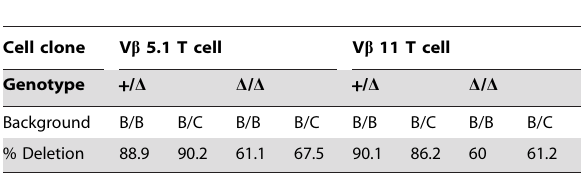
Figure 2. Thymic negative selection was partially reduced in the Foxn1 D / D mutant mice. Foxn1 D / D /BALB/c mice were generated by backcrossing Foxn1 D / D mice (H-2 b , IE - ) to BALB/c (H-2 d , IE + ) for more than 5 generations. Before and after backcrossing, the expressions of V b 5.1 and V b 11 were measured on CD4 T cells. A, histograms showing representative profiles of V b 5.1 and V b 11 expressions on gated CD4 T lymphocytes from Foxn1 + / D , Foxn1 D / D and BALB/c mice. B and D, individual analyses of V b 5.1 and V b 11 expression on CD4 T cells from Foxn1 + / D , Foxn1 D / D and BALB/c mice before backcrossing. C and E, individual analysis of the percentage of V b 5.1 and V b 11 from Foxn1 D / D mice after backcrossing. C/C: C57BL6 background (IE 2 /IE 2 ); B/B: BALB/c background (IE + /IE + ); B/C: BALB/c/C57BL6 (IE + /IE 2 ). (*, p , 0.05). doi:10.1371/journal.pone.0015396.g002 Table 1. Deletion of peripheral TCR V b 5.1 and V b 11 CD4 + T cell clones after backcrossing Foxn1 D / D mice onto the BALB/c genetic